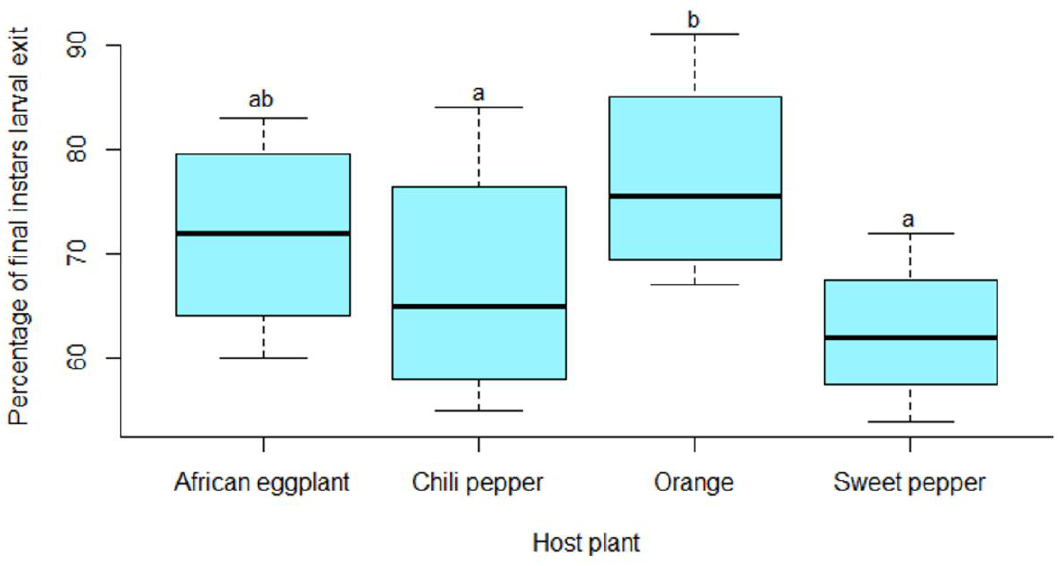
Figure 5. Percentage of surviving Thaumatotibia leucotreta larvae reared on orange and solanaceous vegetables. Boxes caped by the same letter are not significantly different ( p = 0.05, Tukey’s HSD).